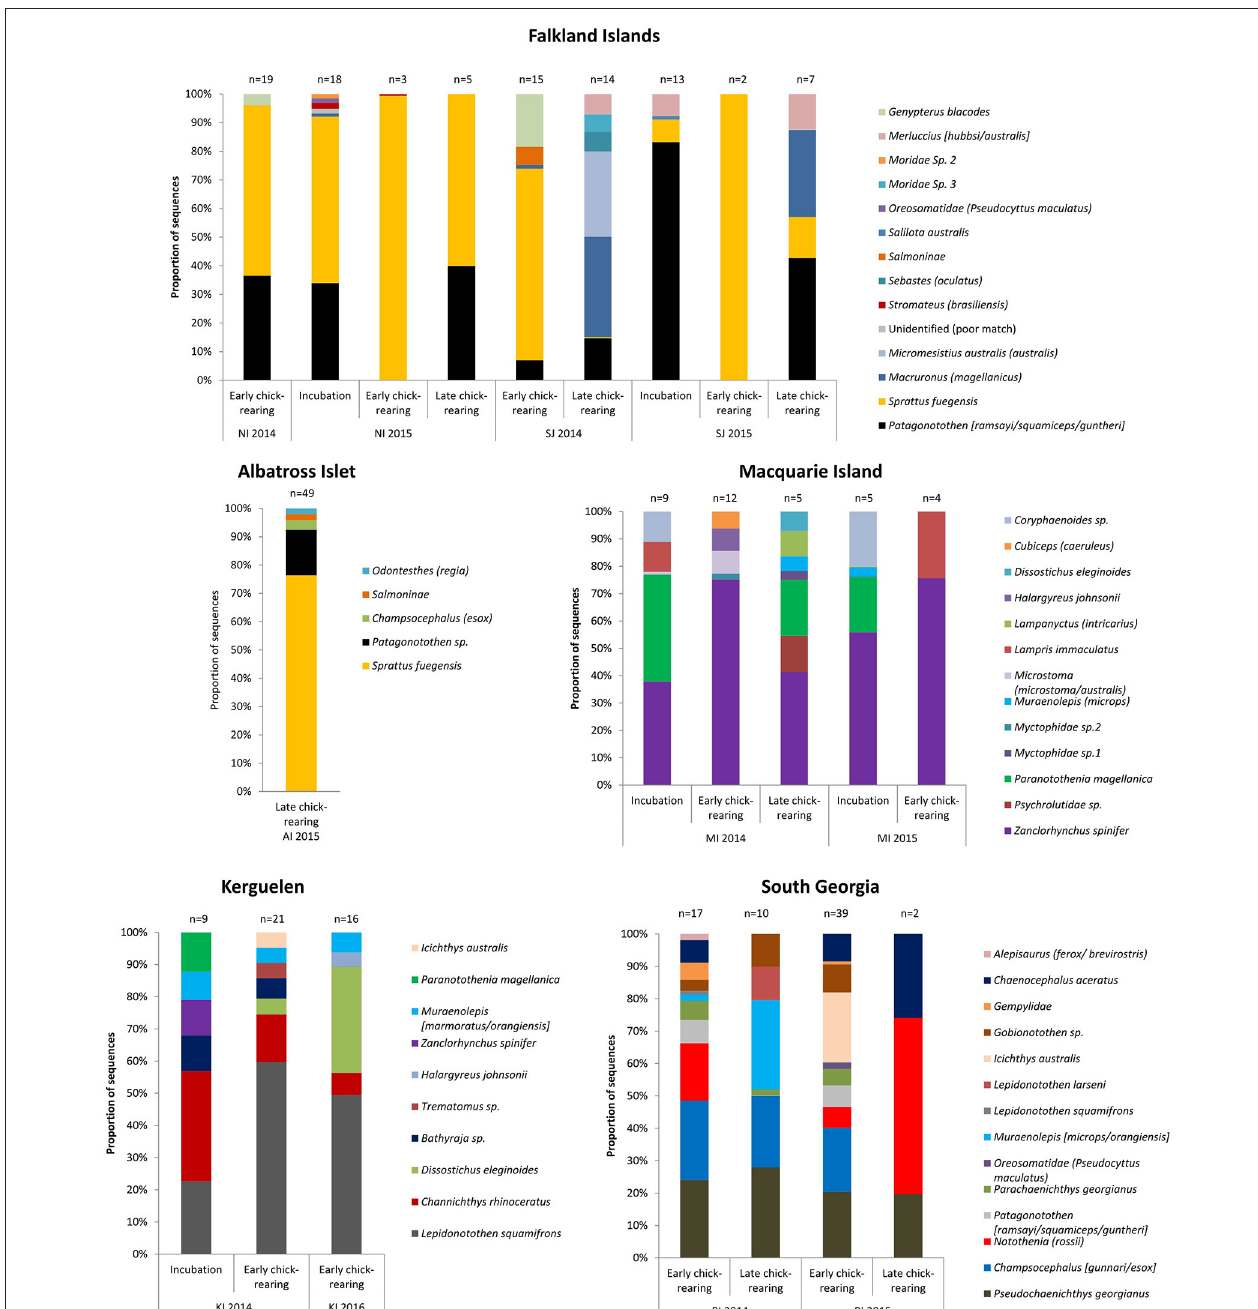
FIGURE 4 | The proportion of fish sequences in the diet of black-browed albatrosses by breeding stage, site and year. Breeding stages were: incubation (October-mid December), early-chick rearing (mid-December-end of January), late-chick-rearing (February onwards). The single sample collected at Macquarie Island during late chick rearing in 2015 was excluded (the DNA sequences were all from the family Bramidae; genus